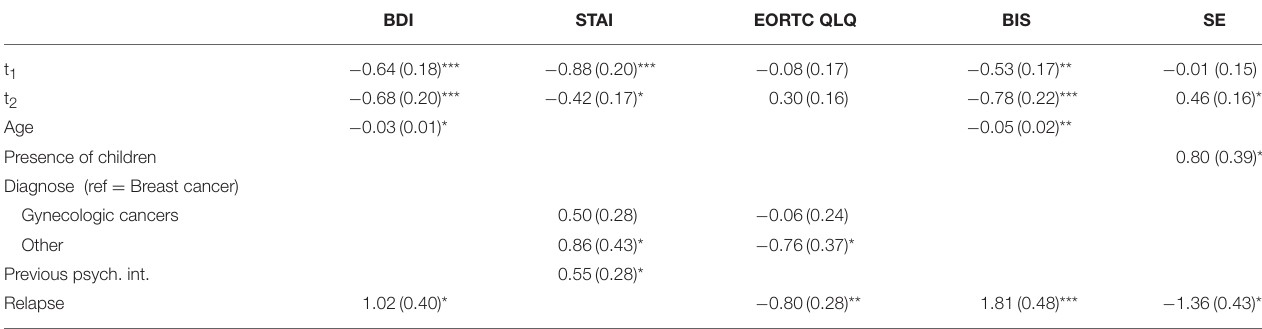
TABLE 3 | Estimates (standard-errors) of the